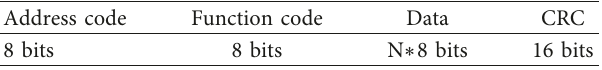
Table 1: The data frame format of Modbus